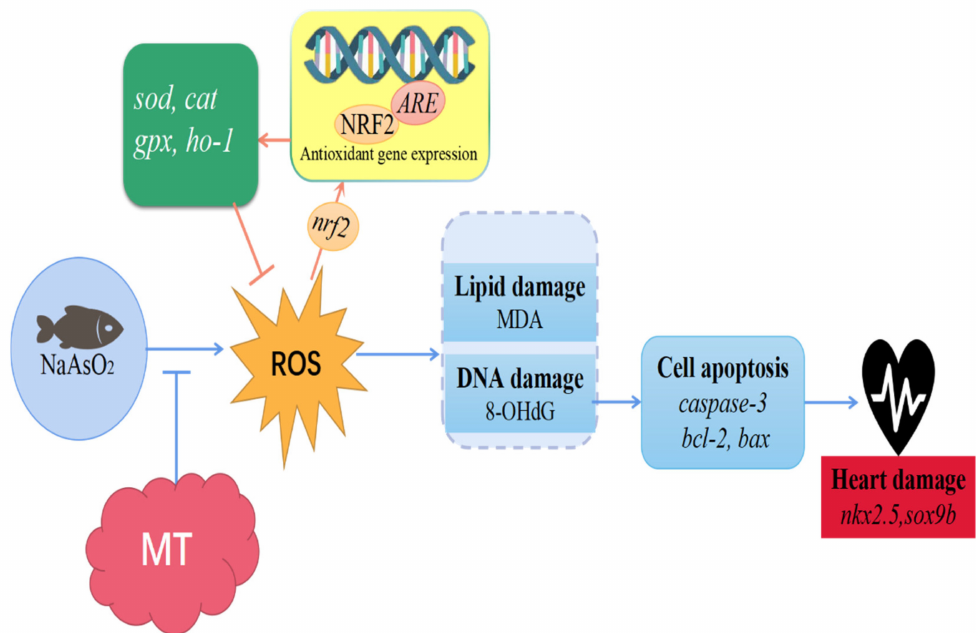
Figure 5. A model indicating that the protection mediated by melatonin reduced the developmental cardiotoxicity of zebrafish embryos induced by NaAsO 2 . Melatonin inhibited the overproduction of ROS caused by the NaAsO 2 exposure, restored the antioxidant defense system, reduced oxidative damage and cell apoptosis, thereby preventing the developmental cardiotoxicity of